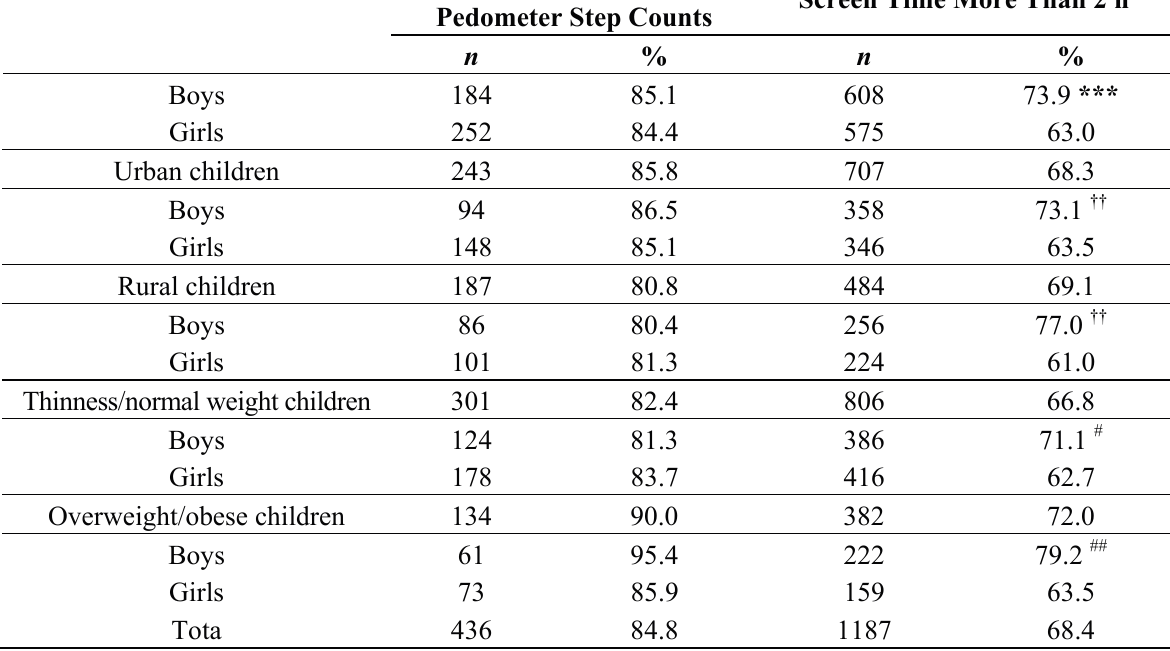
Table 4. Percentage of children not meeting pedometer steps counts recommendation and those exceeding screen time recommendation according to sex, residential area and BMI status. Not Meeting Recommended Screen Time More Than 2 h Pedometer Step Counts